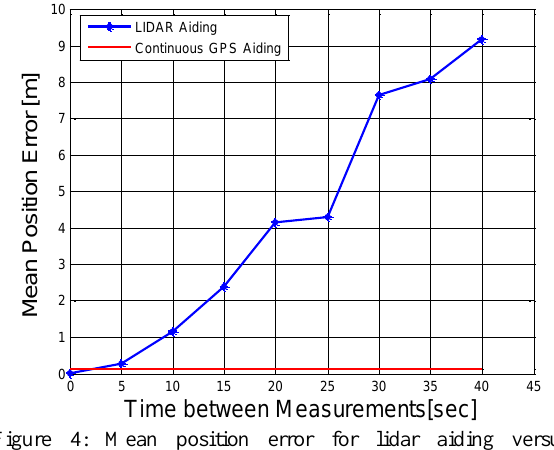
Figure 4: Mean position error for lidar aiding versus